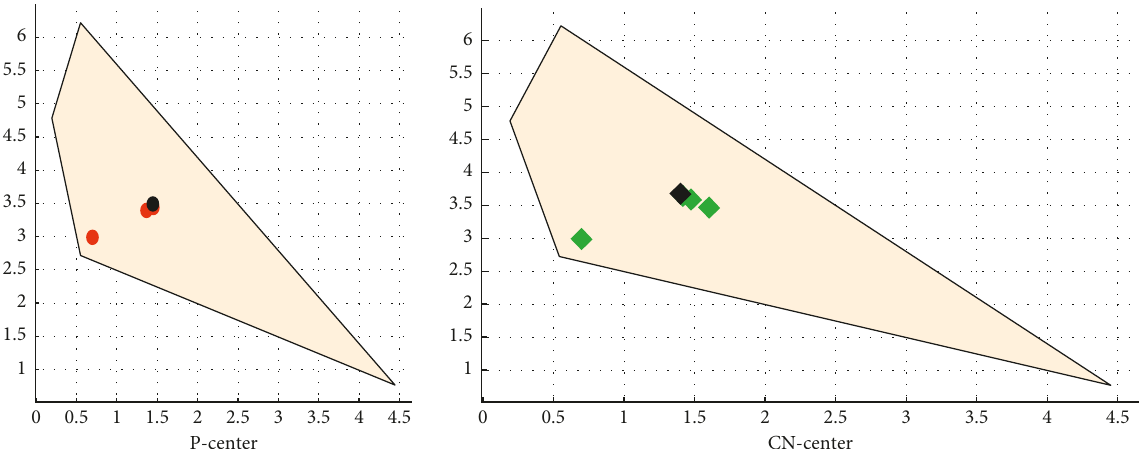
Figure 7: When initial point lies near a wide corner, both P-center and CN-center bear almost equal number of iterations. Table 3: Computational results of randomly generated LPs using MATLAB.